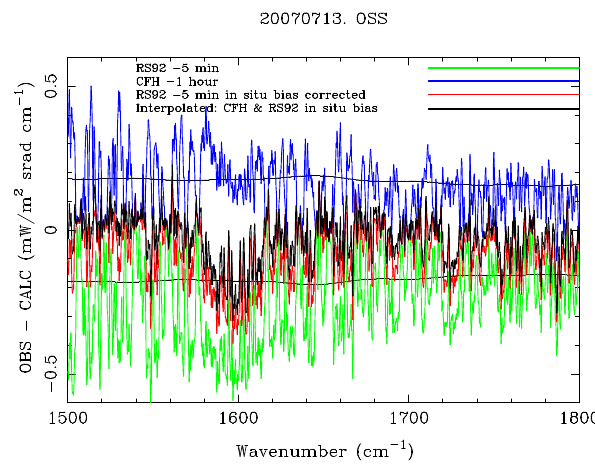
Fig. 6. Residual radiances, IASI observed minus calculated with OSS RTM, for different atmospheric profiles: CFH sonde launched 1h before overpass (blue), RS92 sonde launched 5min before over- pass (green), same sonde but with the “in situ” bias correction (red) and the time interpolated profile (black) using CFH (launched 1h before overpass) and “in situ” bias corrected RS92 (launched 5min before overpass) measurements. Thin black nearly flat lines corre- spond to three sigma IASI instrument